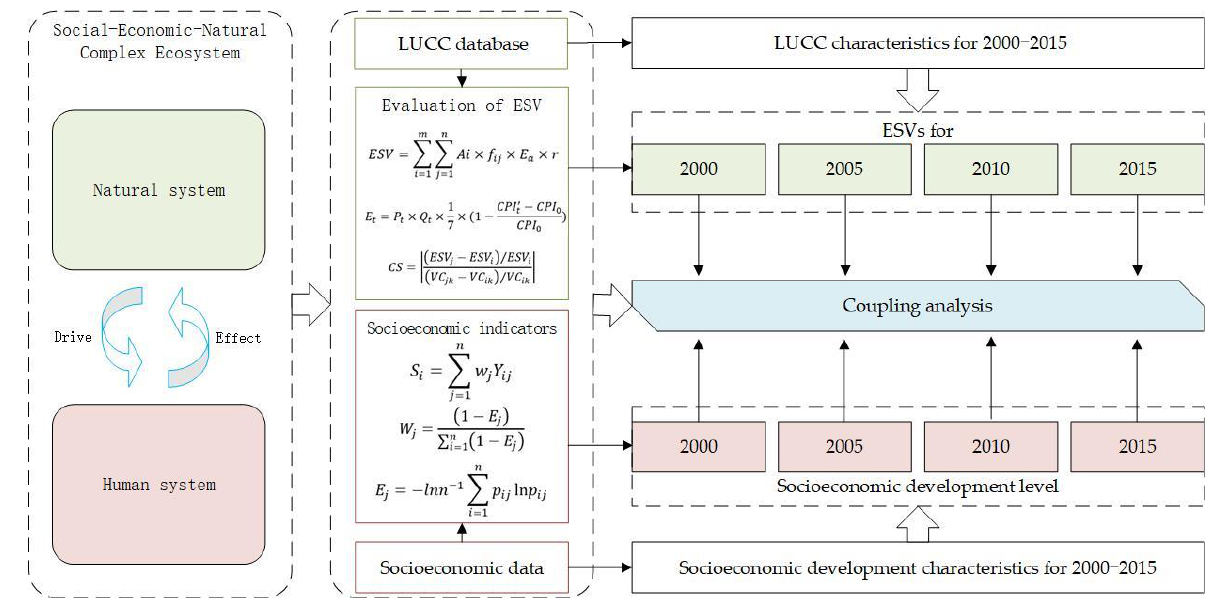
Figure 2. Framework of this study.